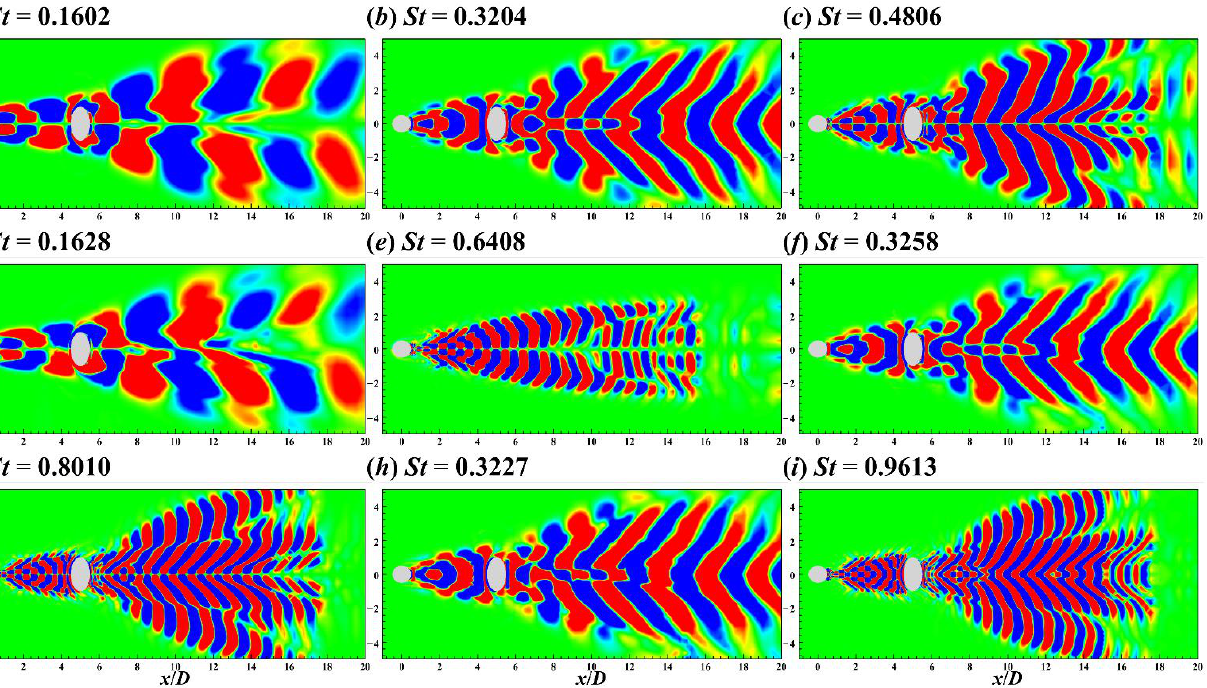
Figure 24. Contours of the St = 0.1602 ( a ), 0.3204 ( b ), 0.4806 ( c ), 0.1628 ( d ), 0.6408 ( e ), 0.3258 ( f ), 0.8010 ( g ), 0.3227 ( h ), and 0.9613 ( i ) DMD modes on the xz plane for the flow around the two crossing cylinders in 60° arrangement.